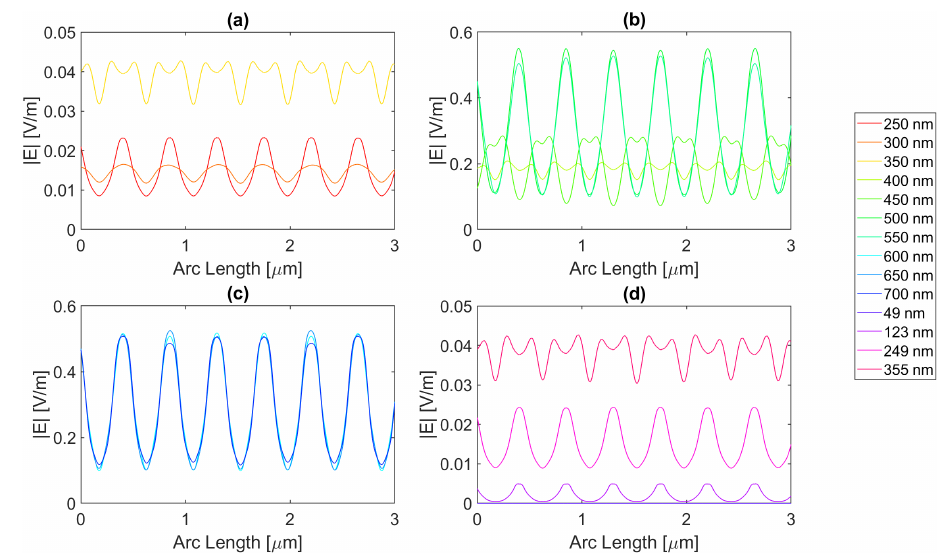
Figure 24. Electric field for the silver triangular nanostructure with a 200 nm base—Probe 1.